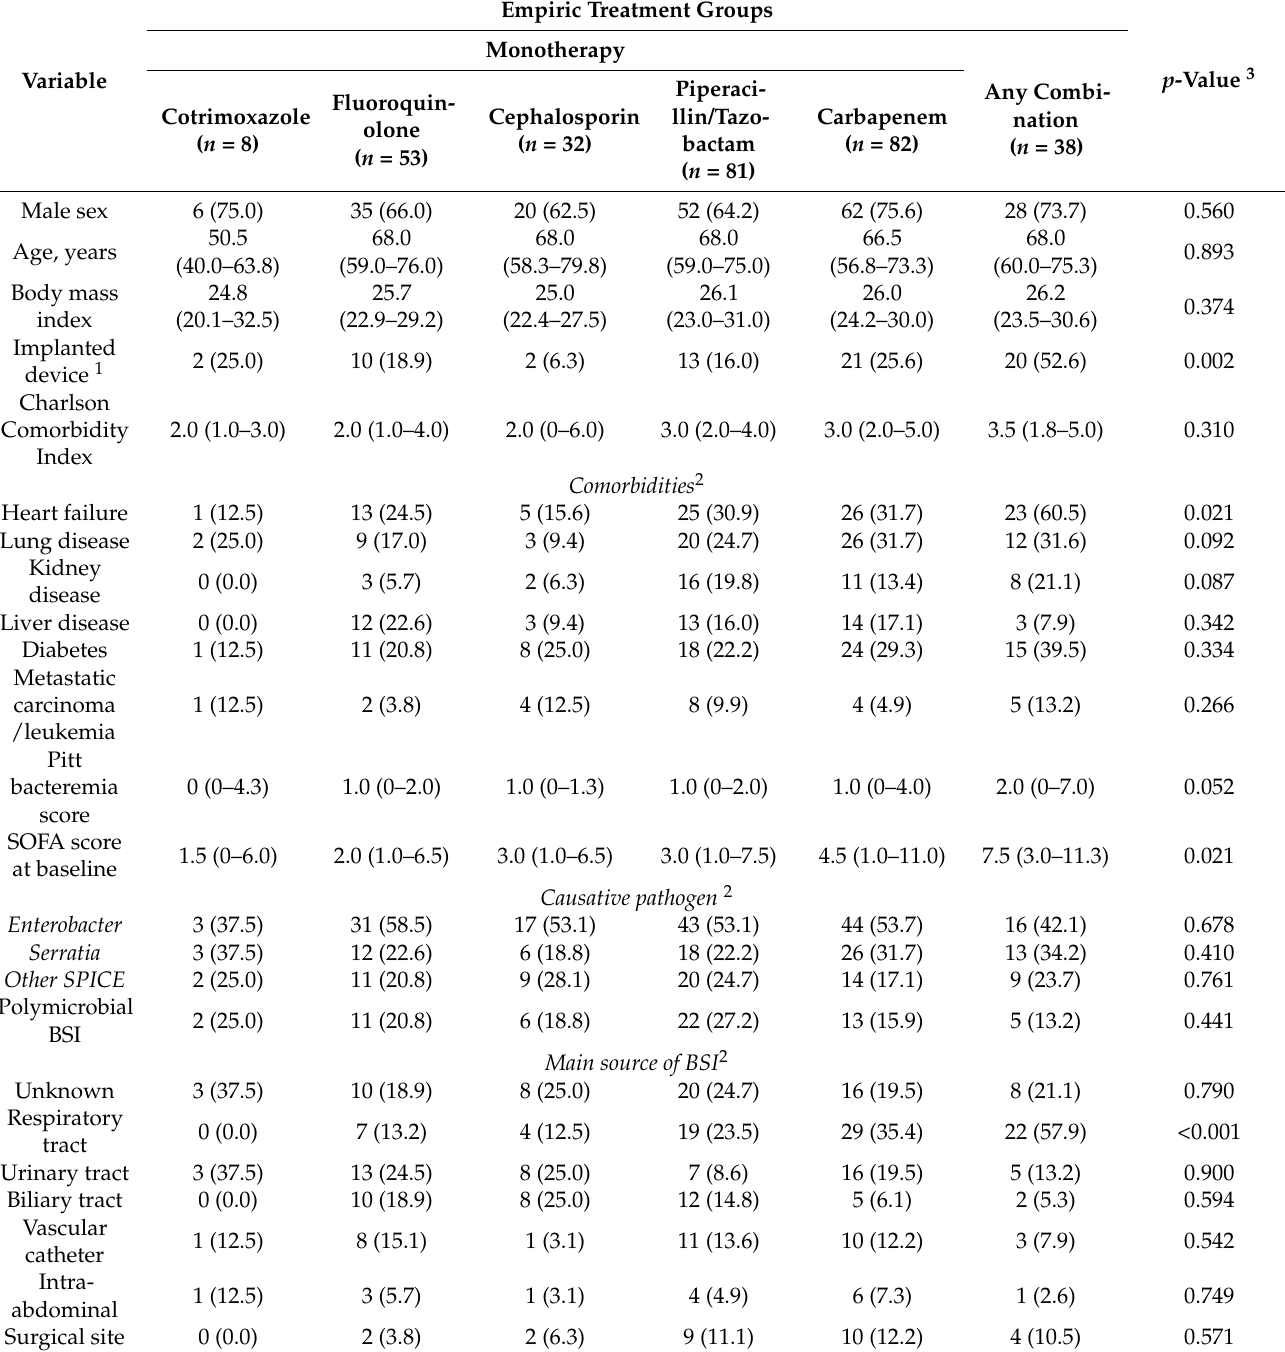
Table 1. Comparison of baseline characteristics, comorbidities, disease severities and bacteremia sources among